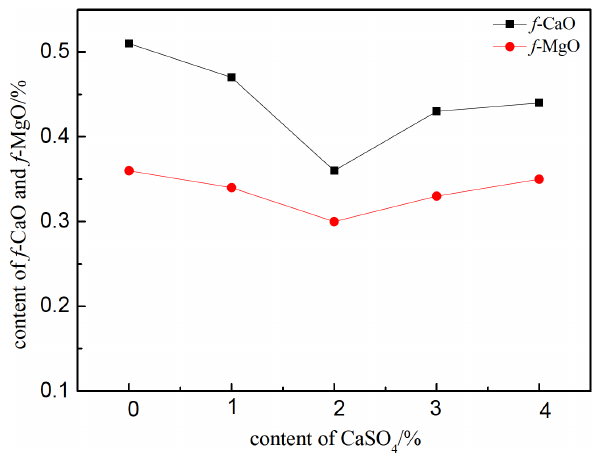
Figure 4: Effect of CaSO 4 on the f -CaO and f -MgO contents in the reconstructed steel slag.